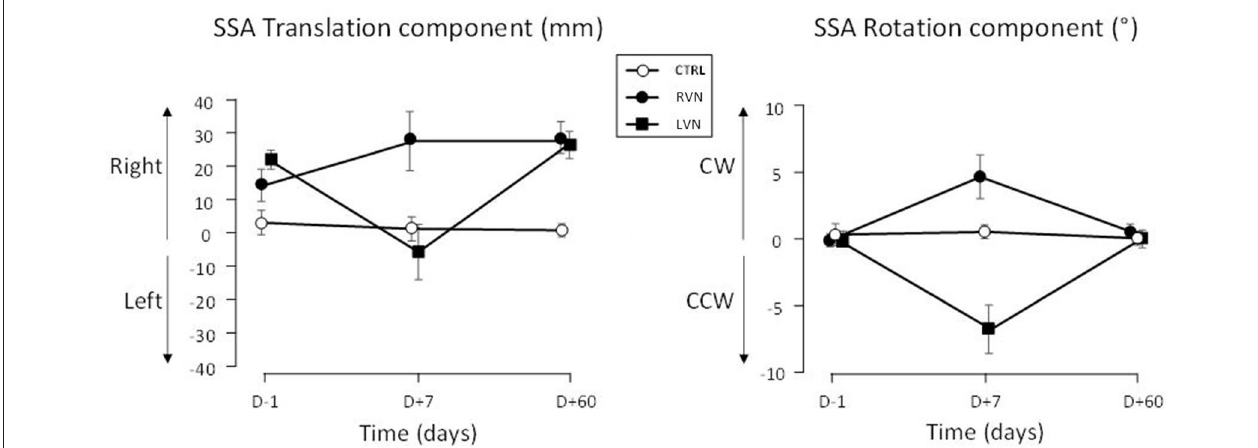
FIGURE 2 | SSA deviation in translation and rotation plotted in left-right coordinates. The SSA is reported for patients with LVN (filled squares) and RVN (filled circles), and healthy controls (open circles). Positive signs indicate rightward translation and clockwise (CW) rotation. CCW: counterclockwise. The bars show the standard errors.